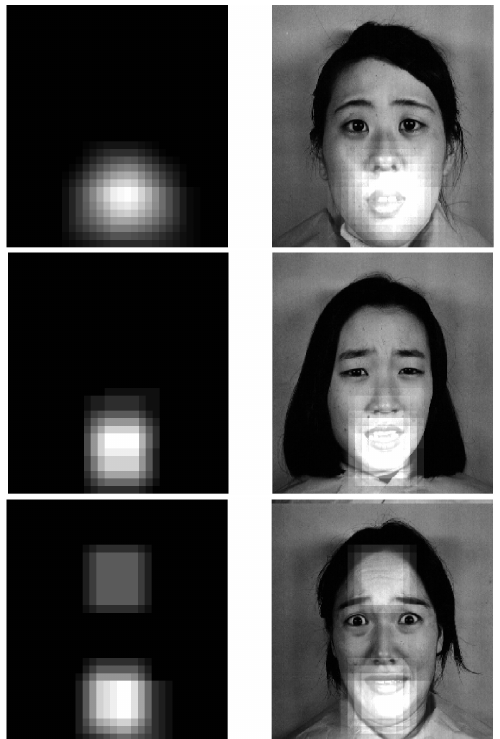
Figure 13. The important regions for three images of fear.